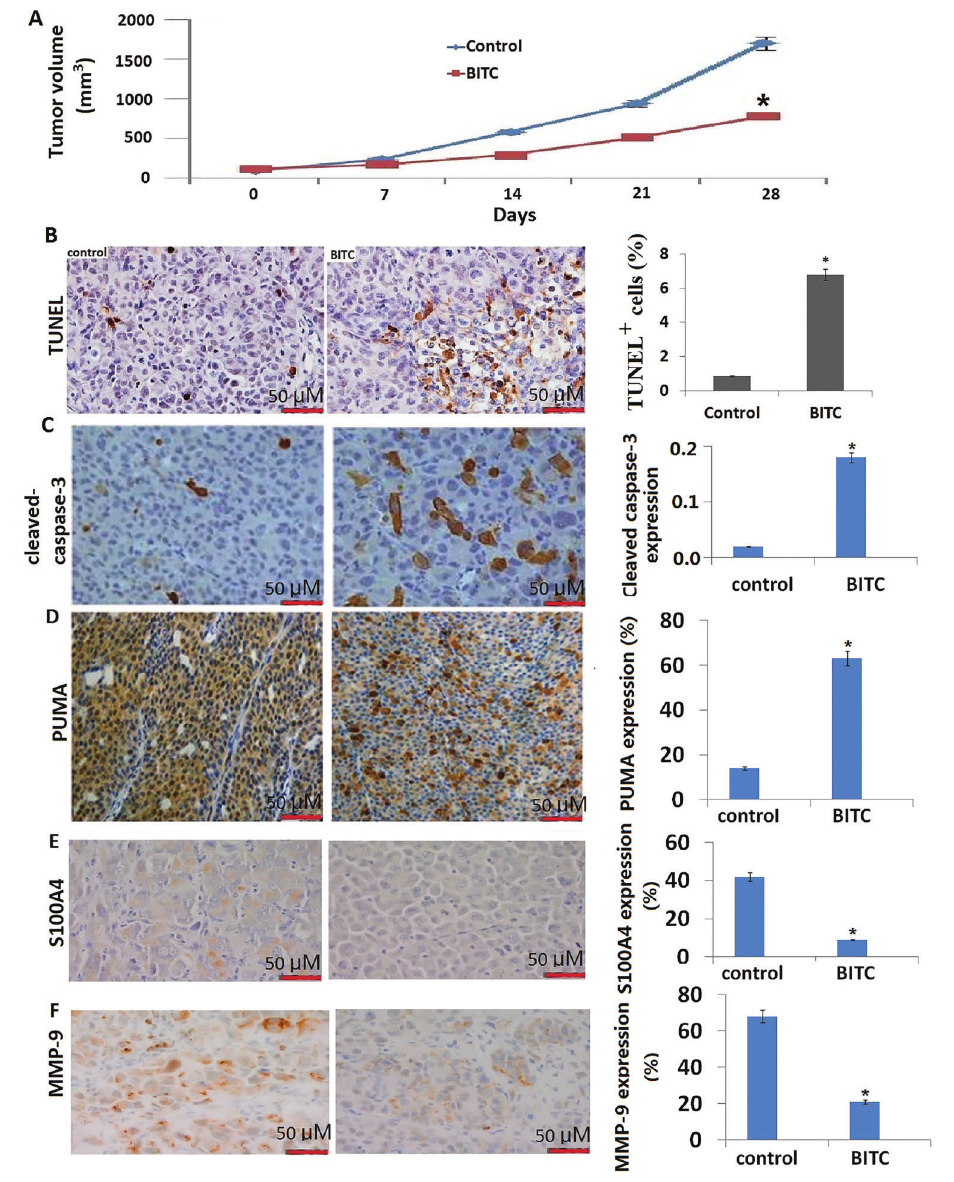
Figure 4. Benzyl isothiocyanate (BITC) inhibited growth of SCC9 cells subcutaneously implanted in nude mice. A , Average tumor volume in vehicle-treated control mice and BITC-treated mice. B , Representative TUNEL-positive apoptotic bodies in tumor section and quantitation of TUNEL-positive apoptotic bodies; C – F , Representative images for cleaved-caspase-3, p53-upregulated modulator of apoptosis (PUMA), S100A4, and MMP-9 (200 (cid:2) magni fi cation; bars: 50 m M). Data are reported as means ± SE. *P o 0.05 compared to control (Student ’ s t